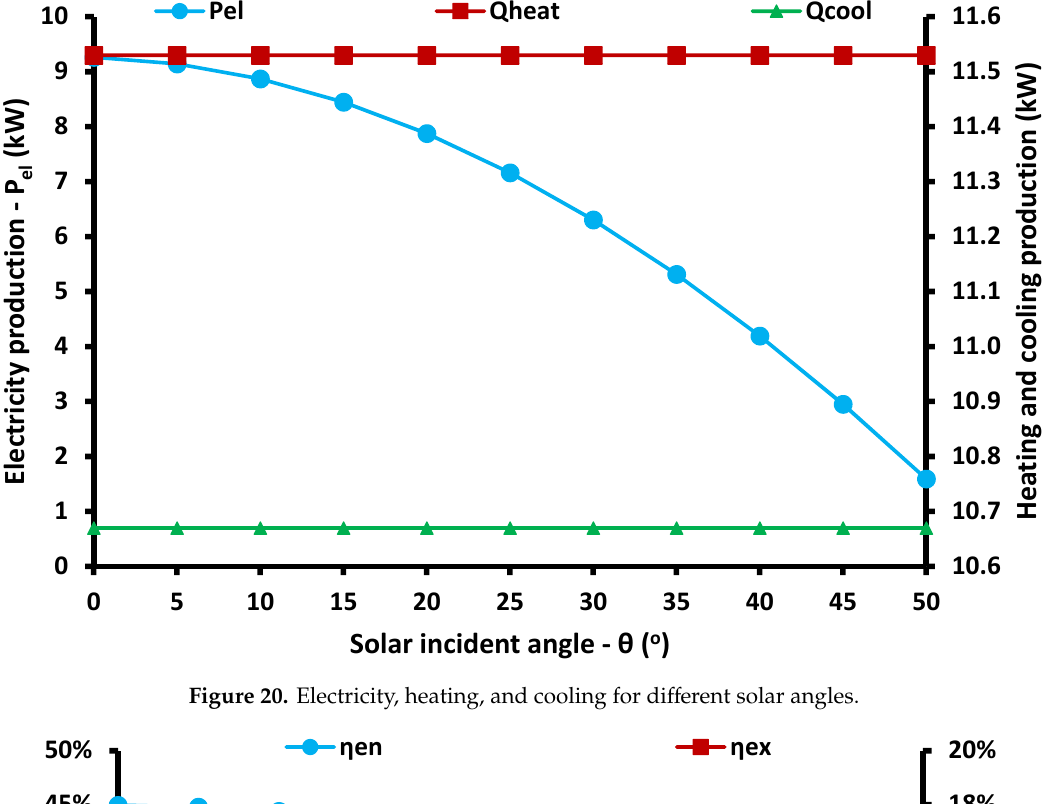
Figure 20. Electricity, heating, and cooling for different solar angles.